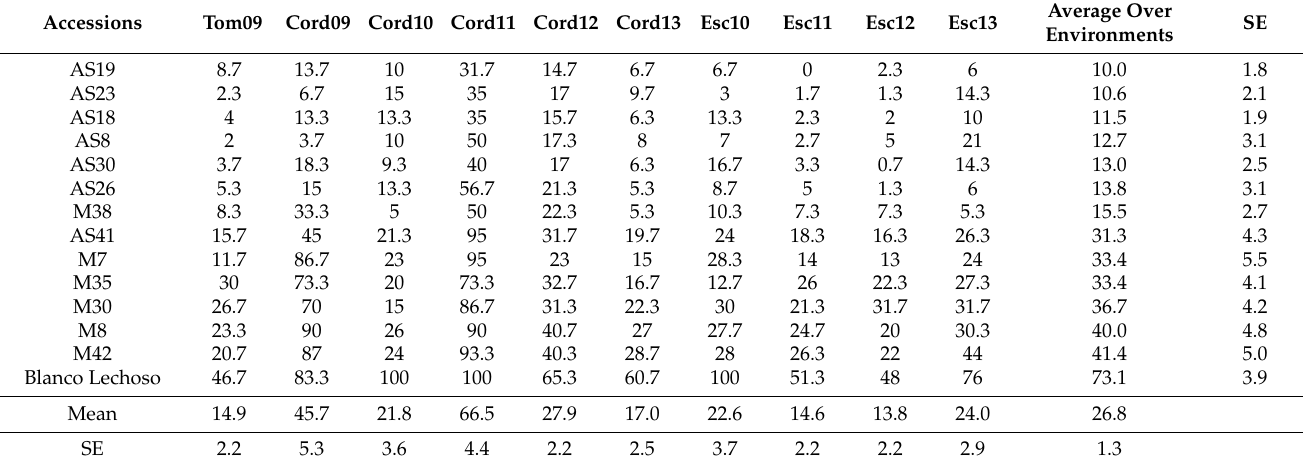
Table 5. Ascochyta blight (%) of 14 chickpea accessions grown at 10 location–year